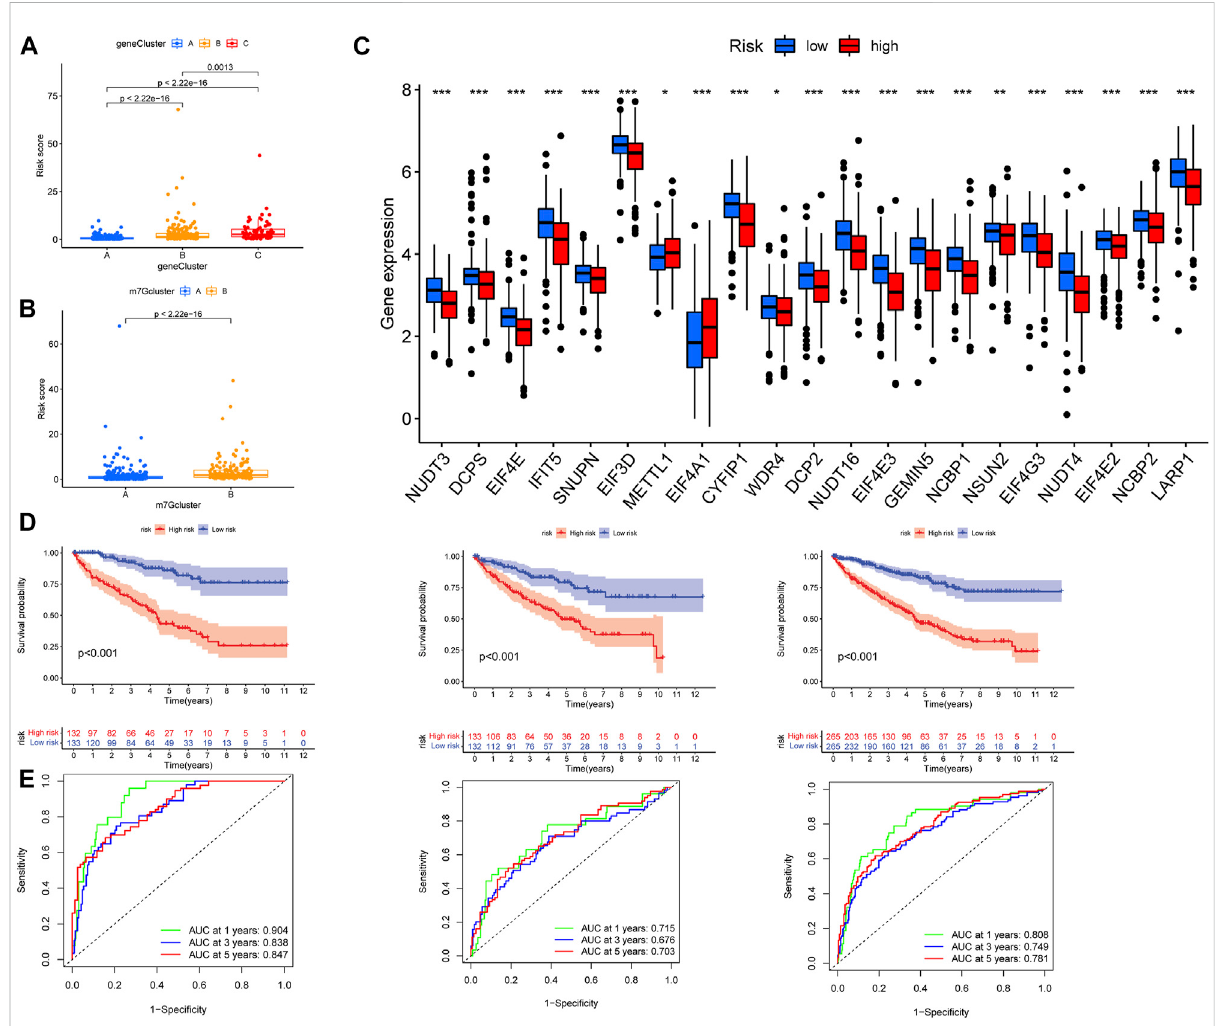
Veri fi cation of prognostic model. (A) Differential analysis of risk scores for prognosis-related gene subtypes. (B) Differential analysis of risk scores for m7G subtypes. (C) Expression difference in m7G-related genes in high- and low-risk groups. (D) From left to right, the patients in the train group, the test group, and all patients analyzed for survival. (E) From left to right, the patients in the train group, the test group, and all patients analyzed for ROC curves. ROC, receiver operating